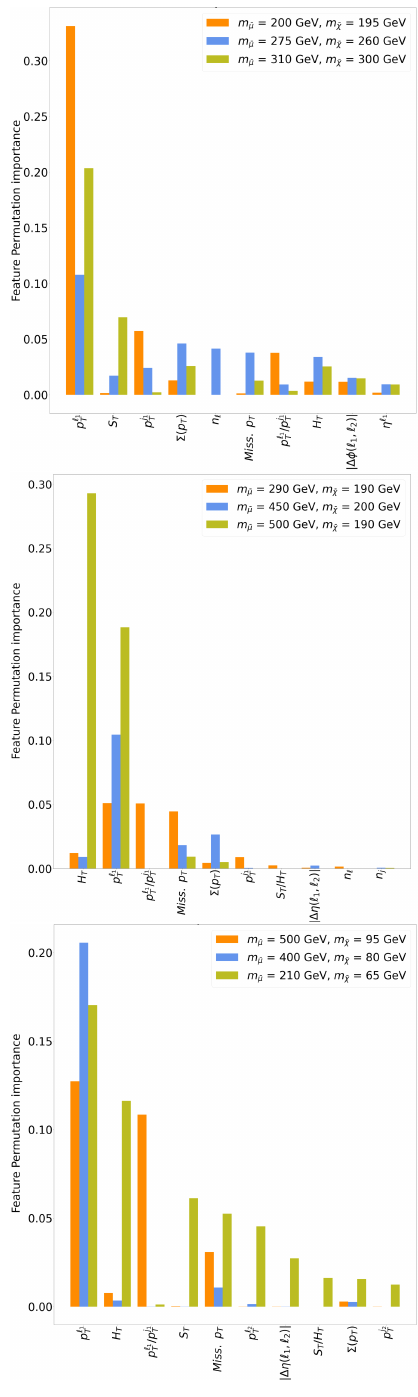
Figure 3 . Sample Shapley feature importance plots (left) and permutation importance plots (right) for compressed , neutral , and separated regimes. The Shapley plots are for ( m ˜ µ , m ˜ χ ) = (200 , 195) GeV (top), ( m ˜ µ , m ˜ χ ) = (290 , 190) GeV (middle) and ( m ˜ µ , m ˜ χ ) = (400 , 80) GeV (bottom), while the permutation plots are divided into compressed , neutral and separated mass ratios from top to